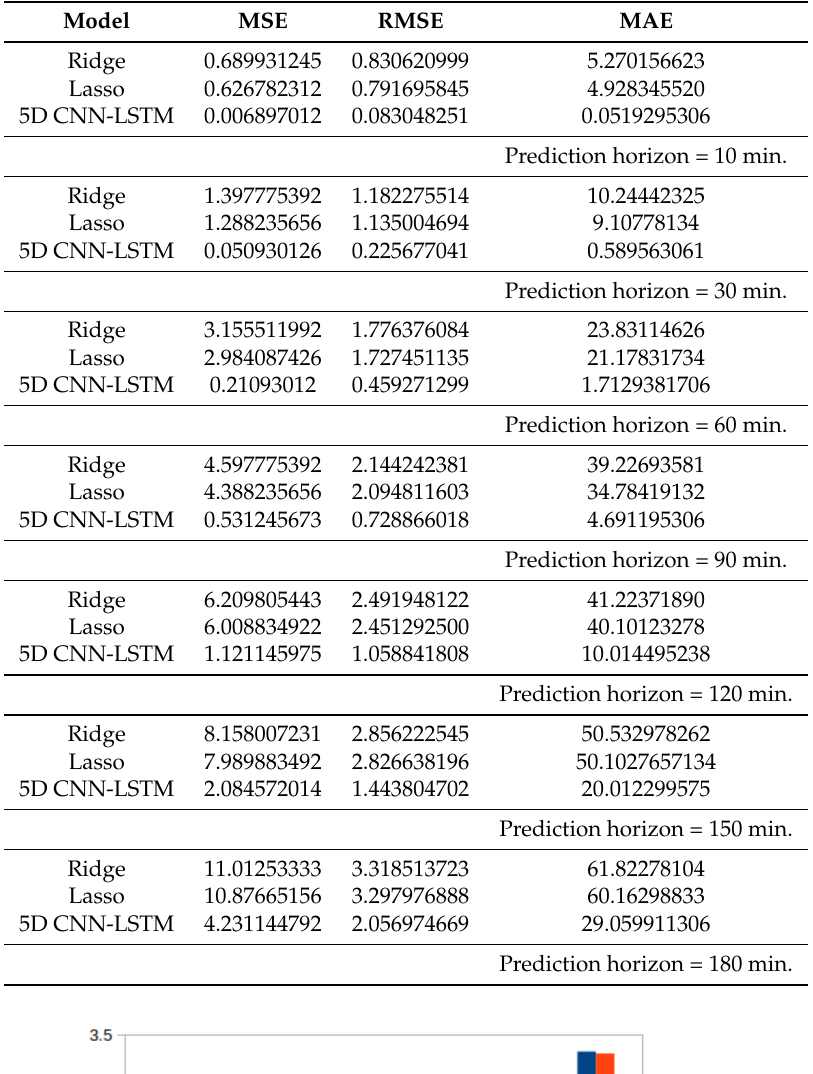
Table 4. Performance comparison of the proposed model with competitive benchmarks.